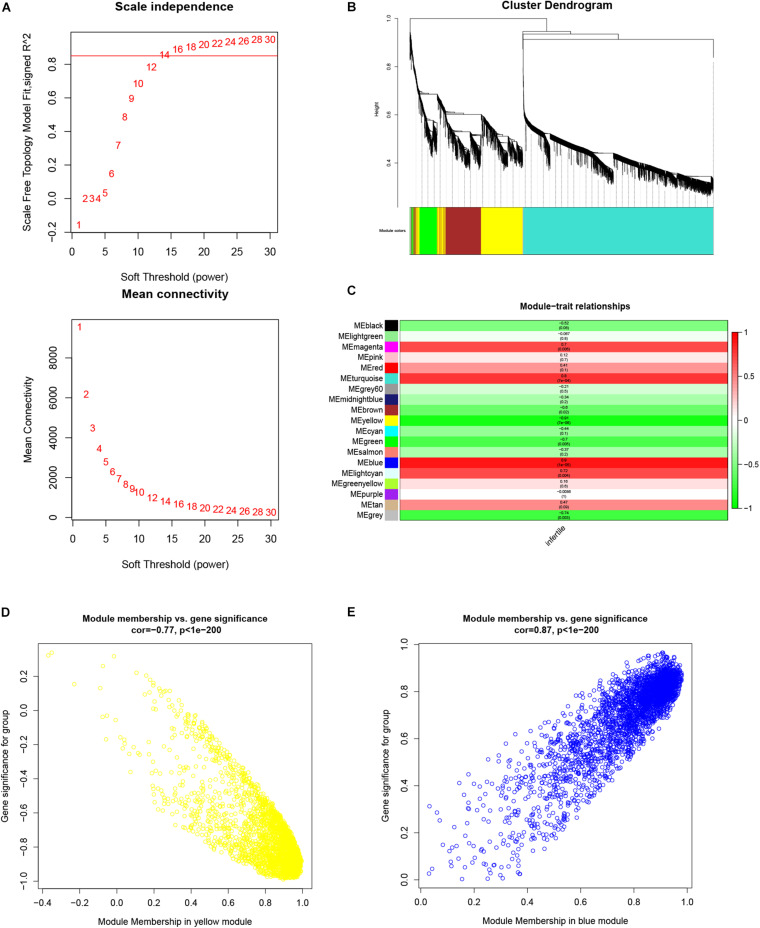
Weighted gene co-expression network analysis of lncRNAs and mRNAs associated with infertility in women with endometriosis. (A) Analysis of the scale-free fit index and the mean connectivity for various soft threshold powers (β). (B) Dendrogram for all expressed lncRNAs and mRNAs clusters based on a dissimilarity measure (1-TOM). (C) Determination of module–trait relationship of infertility in endometriosis. Each row indicates a module eigengene (the principal component of gene expression), while the heatmap represents a clinical trait of infertility in endometriosis. (D,E) Scatterplots of module eigengenes related to infertility in women with endometriosis in the yellow and blue co-expression modules.